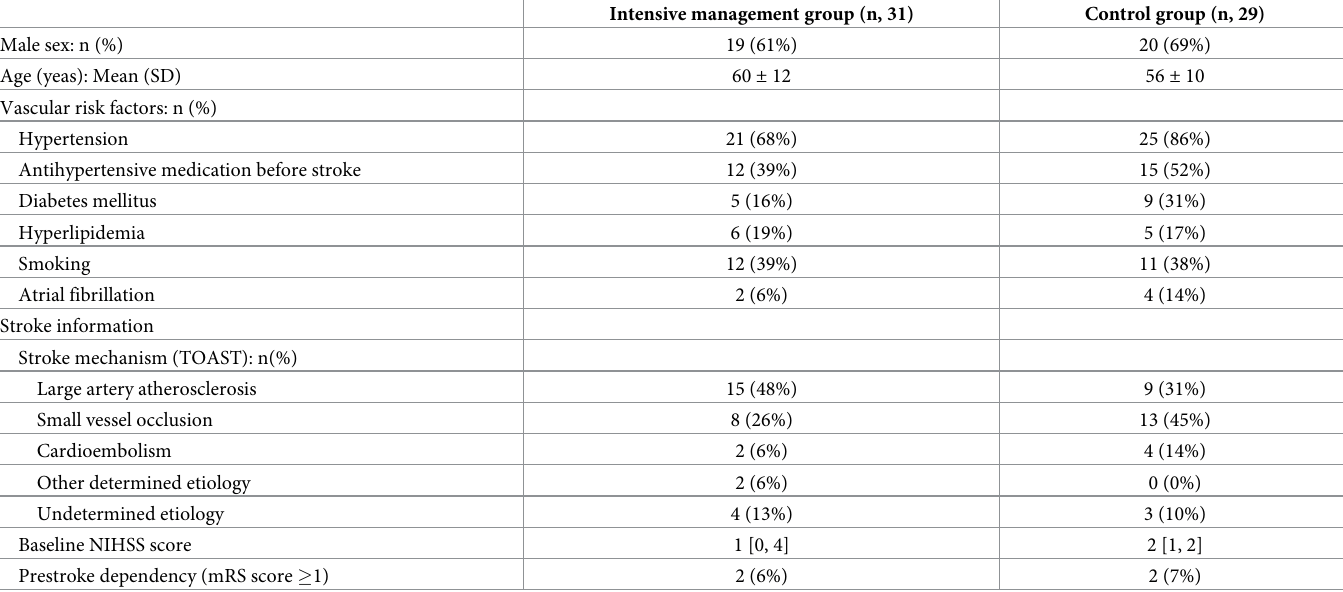
Table 1. Characteristics of the patients at